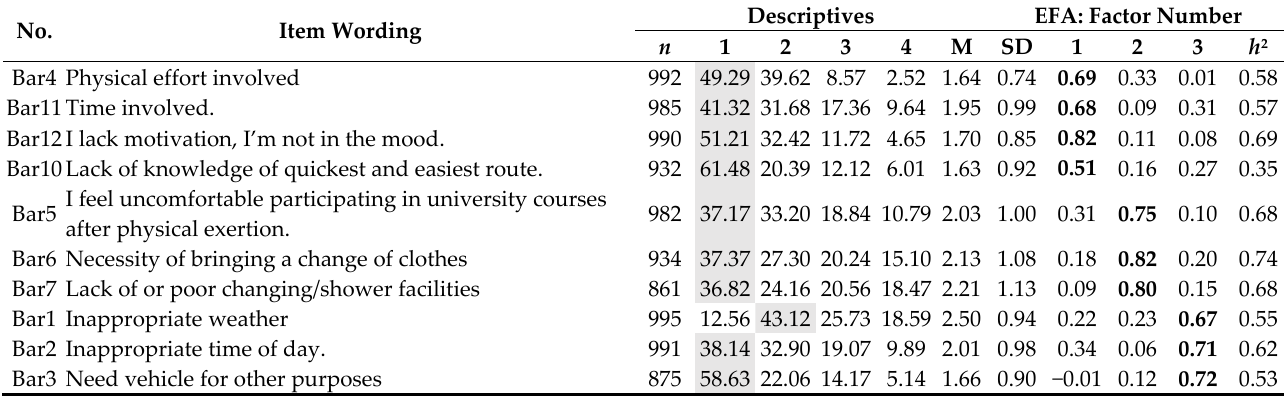
Table A6. Item’s descriptives (frequencies in %; 1 = totally disagree; 2 = more likely to disagree; 3 = more likely to agree; 4 = totally agree), factor loadings and communalities ( h 2 ) of the explorative factor analysis (EFA) of barrier items. No.